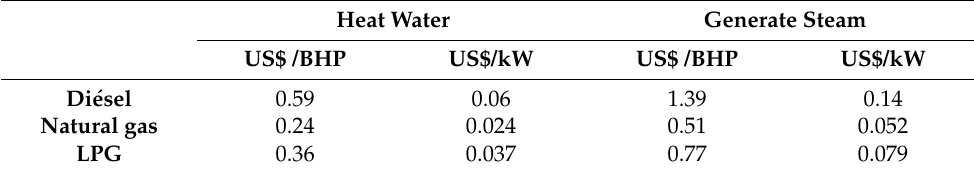
Table 5. Comparison of specific fuel costs (kg) per